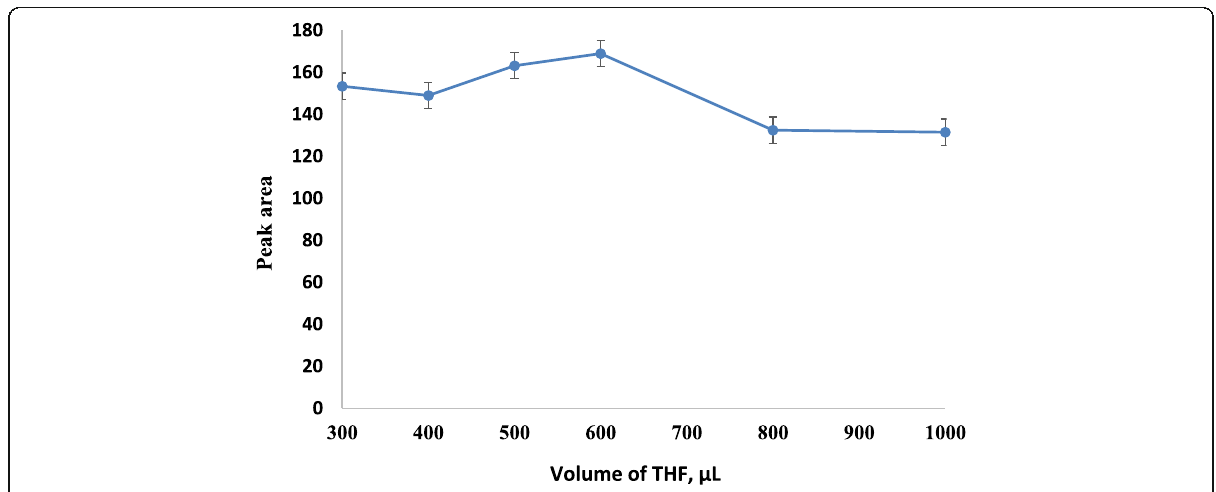
Fig. 5 Effect of THF volume on the extraction efficiency of DKT ( n =